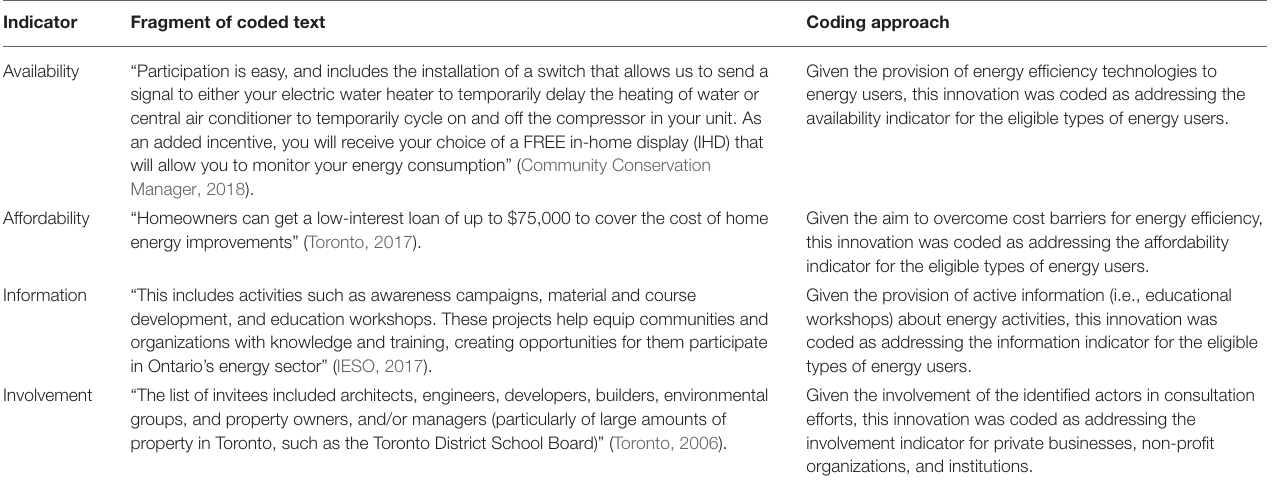
TABLE 2 | Examples of coded text for each